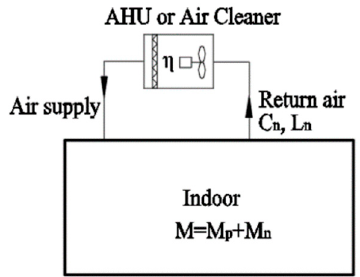
Figure 11. Schematic diagram of the decentralized system.